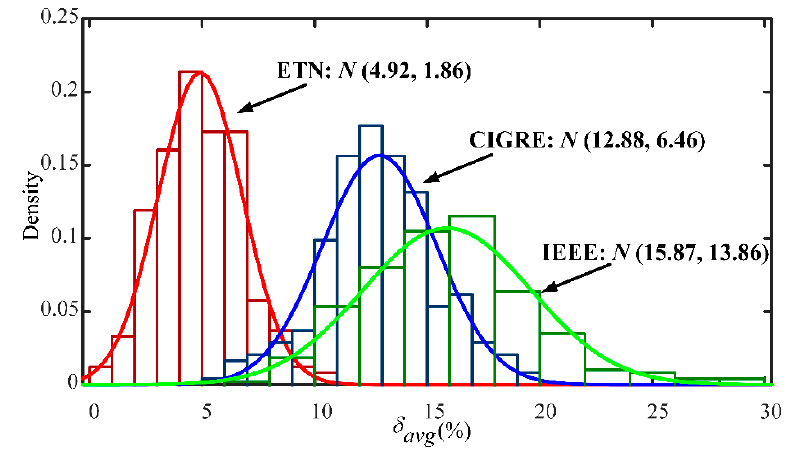
Figure 8. Frequency distribution histogram of the average absolute relative error δ avg of the methods under the verification test conditions.